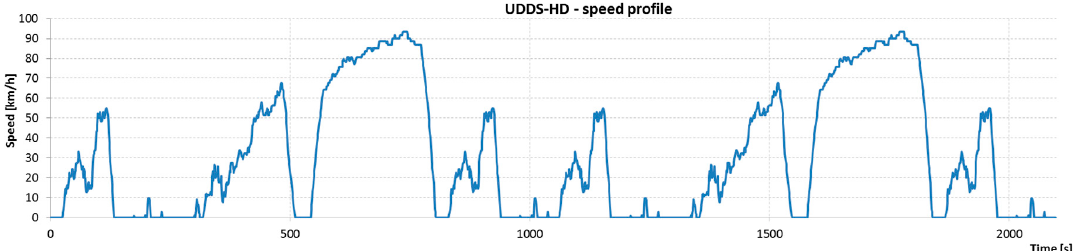
Figure 14. UDDS-HD driving cycle.